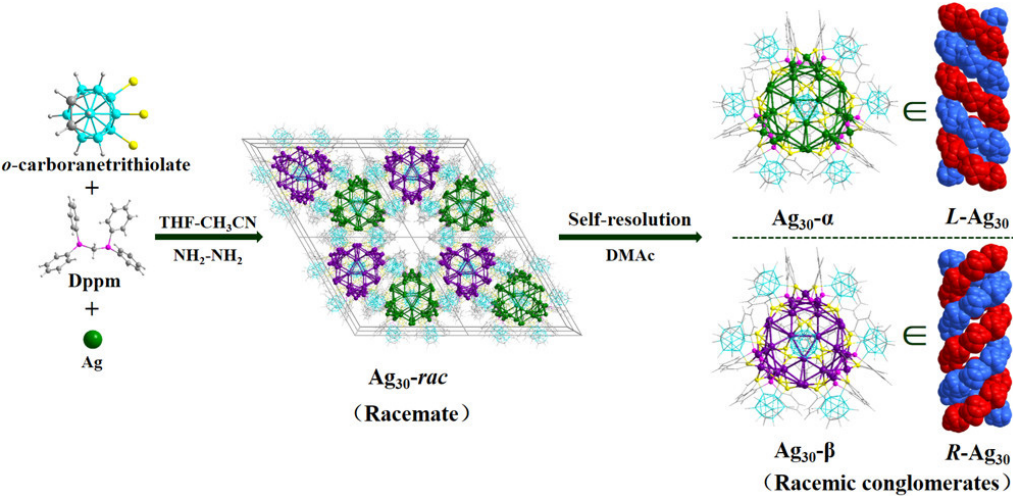
Figure 4. Synthesis and self-decomposition of Ag 30 -RAC. Copyright 2020 American Chemical Soci- ety.